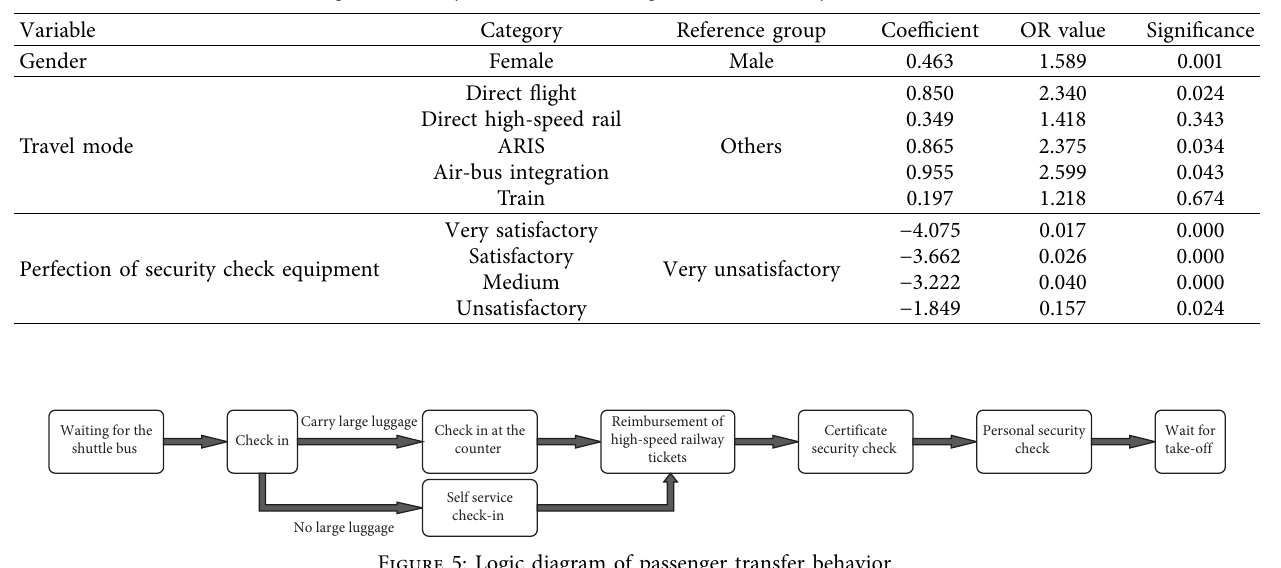
Table 7: Regression analysis of the infuencing factors of security check reservation time.